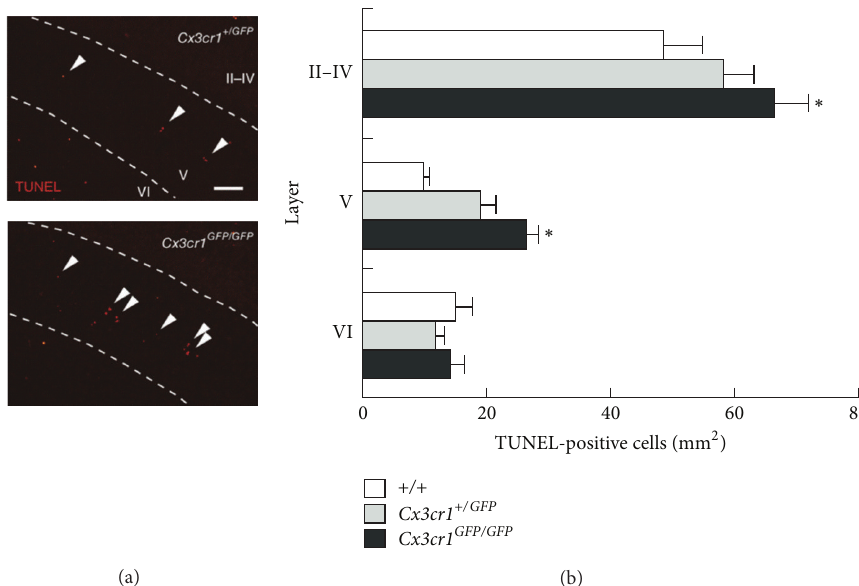
Figure 1: Fractalkine/CX3CR1 signaling controls survival of cortical neuron during early postnatal development. (a) Apoptotic cells revealed by TUNEL staining in the cortex of Cx3cr1 +/GFP (top) and Cx3cr1 GFP/GFP (bottom) mice at P5. Scale bar represents 100 𝜇 m. The arrowheads indicate TUNEL-positive elements in the layer V of the cortex. (b) Quantification of the TUNEL-positive cells density in different cortical layers. Note the increase of apoptotic cells in the layer V and II–IV in the cortex of Cx3cr1 GFP/GFP . Adapted from